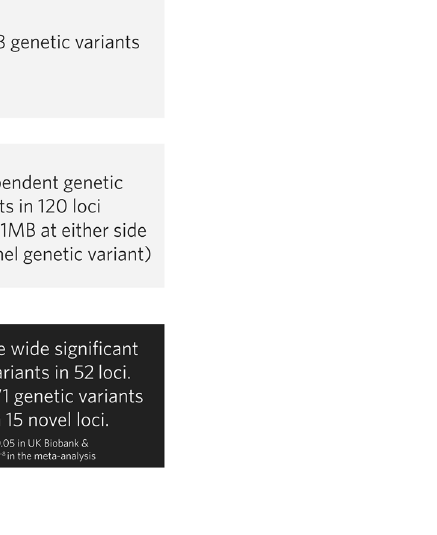
Figure 1. Flowchart of the study